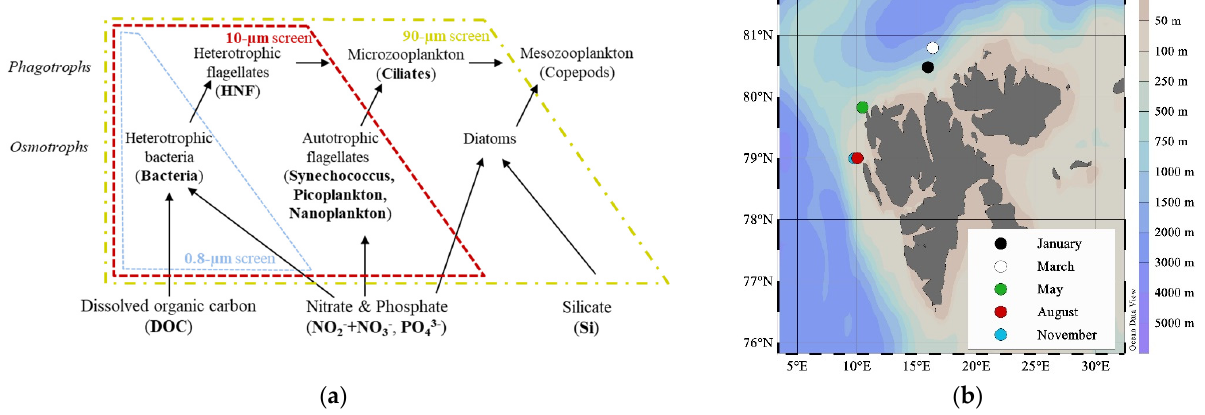
Figure 1. ( a ) Conceptual model of the microbial food web and the experimental manipulations by excluding different groups of phagotrophs (grazers) and osmotrophs (heterotrophic and autotrophic) using screens of different sizes (based on the “minimum” microbial food web model from Thingstad et al., 2007 [15]). Nutrients and organisms that were measured in this study are marked in bold and were placed in this model according to their size class and function. Frames of dashed lines in different colors indicate which organisms are included in the different size fractions. Size fractionation had no effects on the nutrient concentrations at the start of the experiment. ( b ) Location of stations NW of Svalbard sampled at different months in 2014 are indicated by the colors.